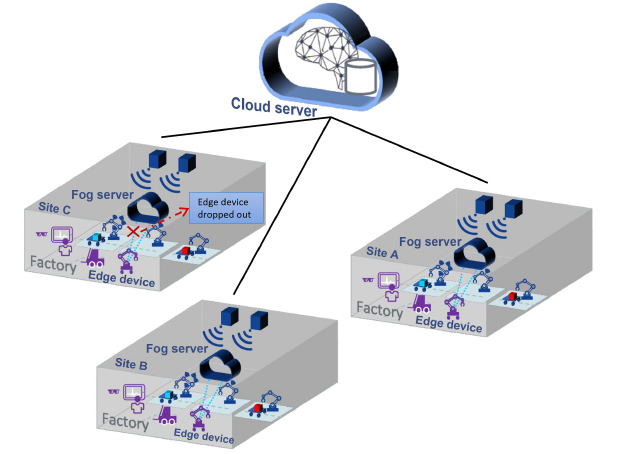
Figure 2. Proposed collaborative PM at the edge, fog, and cloud